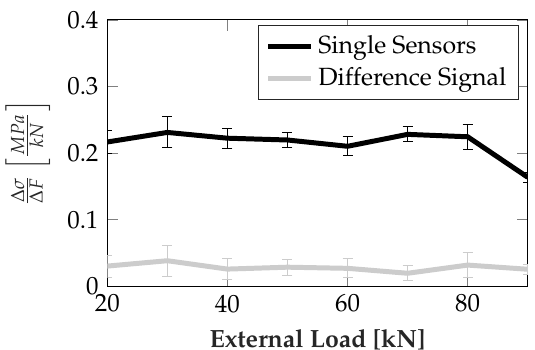
one standard deviation on unloaded raceways ±